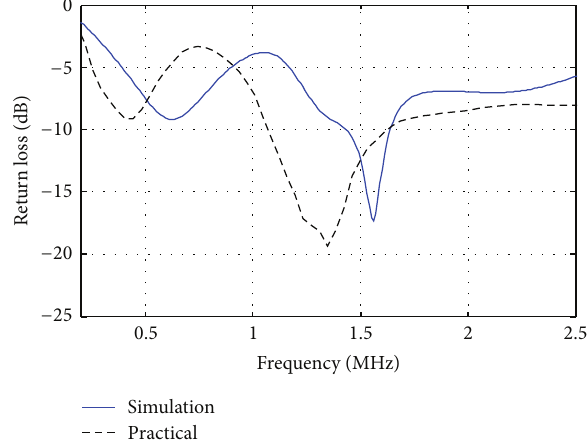
Figure 5: Return loss (S 11 ) of the printed Z-shaped antenna on glossy paper.